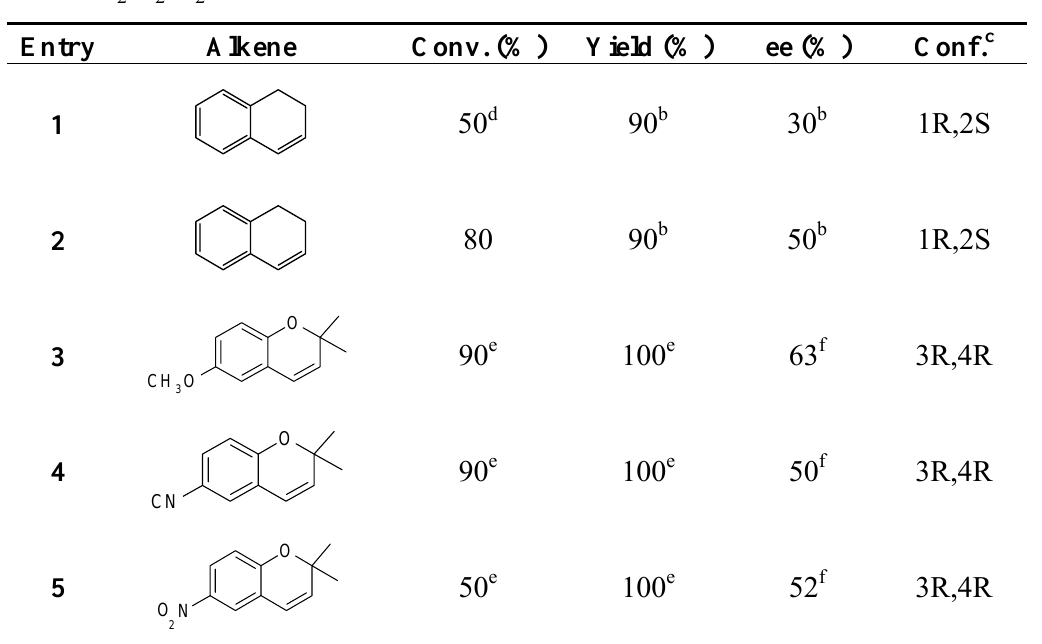
Table 1. Enantioselective Epoxidation reactions of Alkenes with NaClO catalyzed